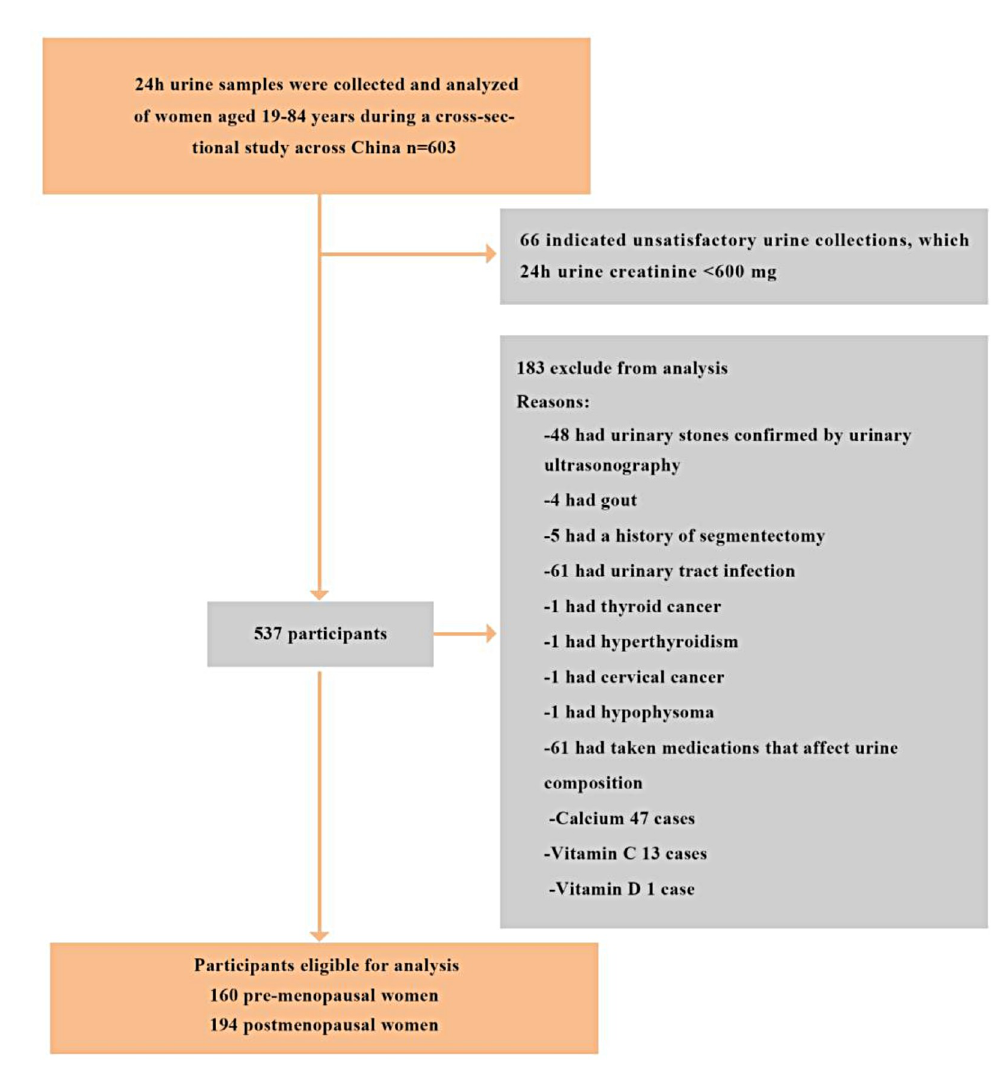
Fig 1. Flow chart of participants identified, included, and